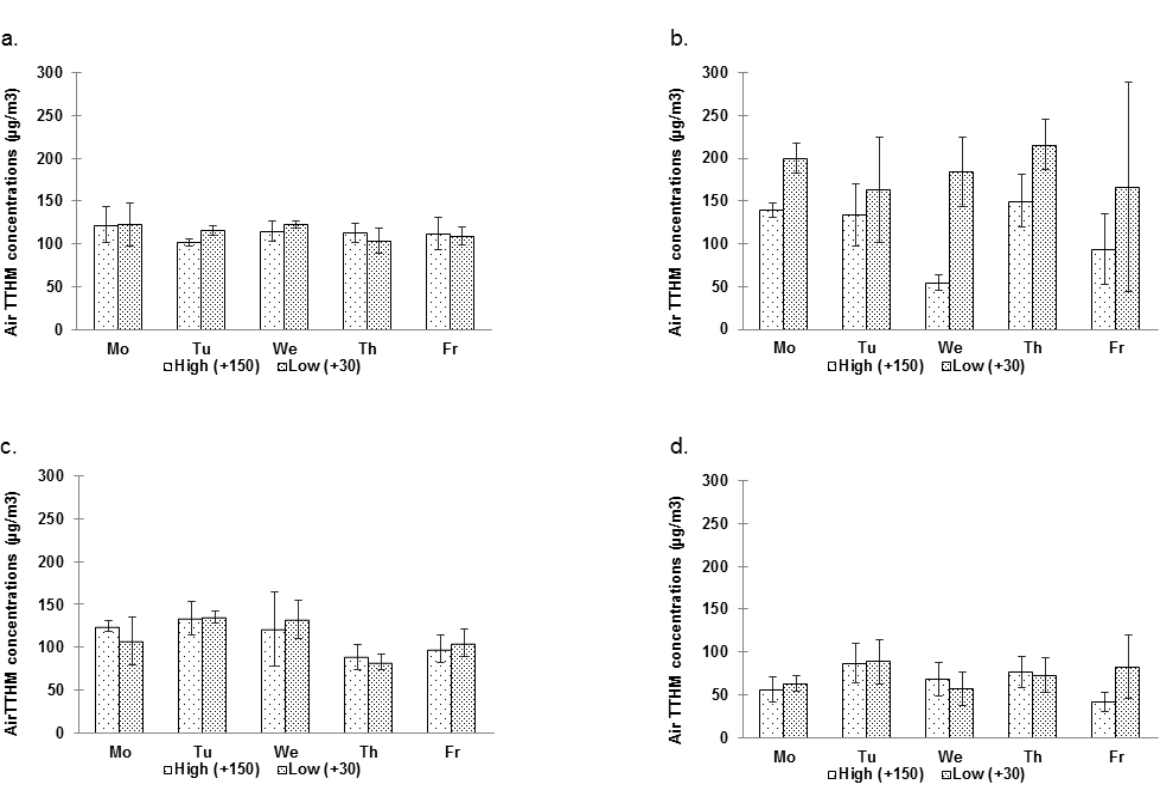
Figure 4. Mean concentrations (µg/L) of TTHMs in the pool air. ( a ) [A]–S1; ( b ) [A]–S2; ( c ) [B]–S1; ( d )